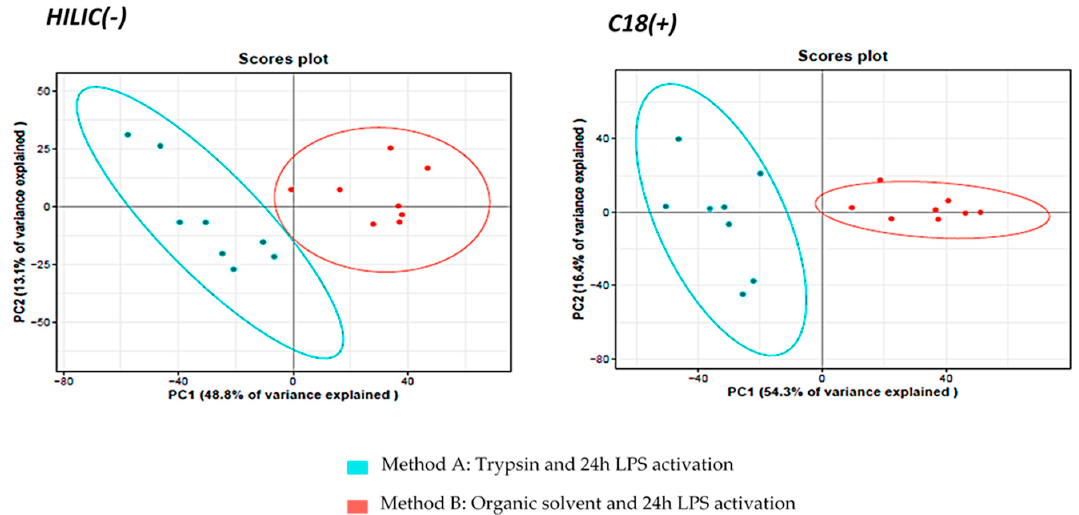
Figure 3. PCA multivariate analysis of the extracted cell samples analyzed under HILIC( − ) and C18(+) conditions.